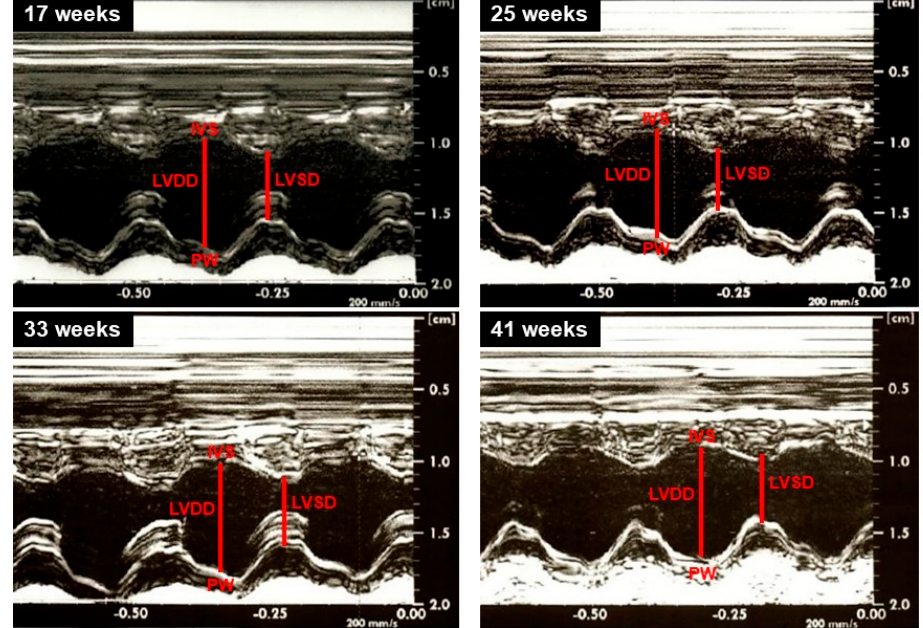
Figure 5. Illustrative left ventricle M-mode echocardiograms from rats at 17th, 25th, 33rd, and 41st week. LVDD and LVSD: left ventricular diastolic and systolic diameters, respectively; PW: left ventricle posterior wall; IVS: interventricular septum.